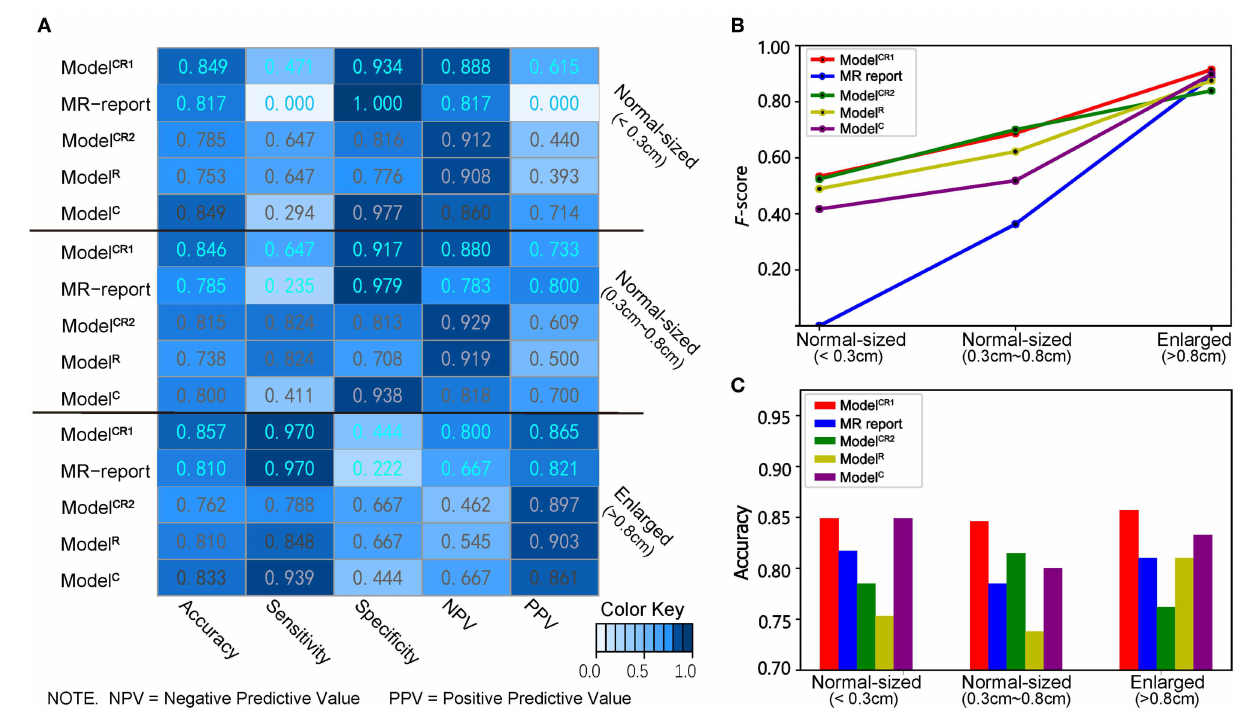
FIGURE 6 | (A) Heatmap of showing the classifiers’ performance in different LN size subgroups. A deeper blue indicates a larger value. (B) Line chart of F -score, (C) histogram of accuracy in three subgroups. Red, blue, green, yellow, and purple lines and boxes, respectively, represent Model CR1 , MR report, Model CR2 , Model R , and Model C